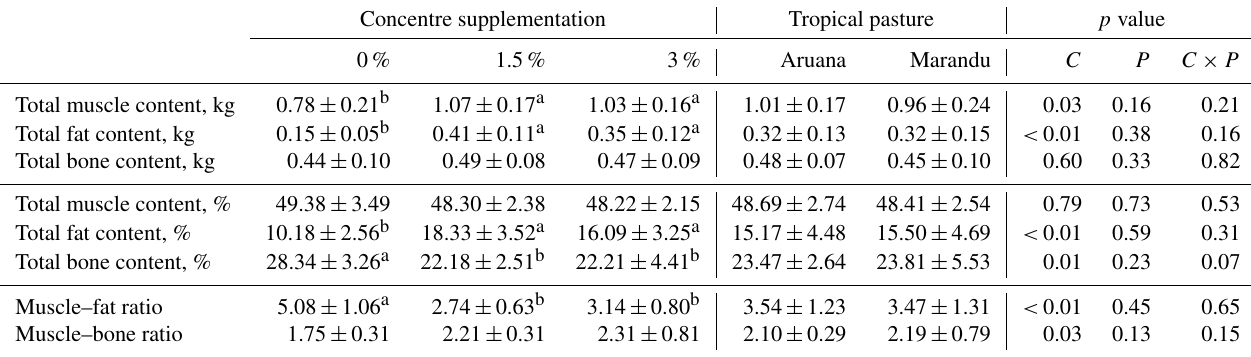
Table 5. Means, standard deviation, and effect of concentrate supplementation ( C ), tropical pasture type ( P ), and interaction ( C × P ) related to composition and muscularity of the leg from the carcass of Suffolk lambs.